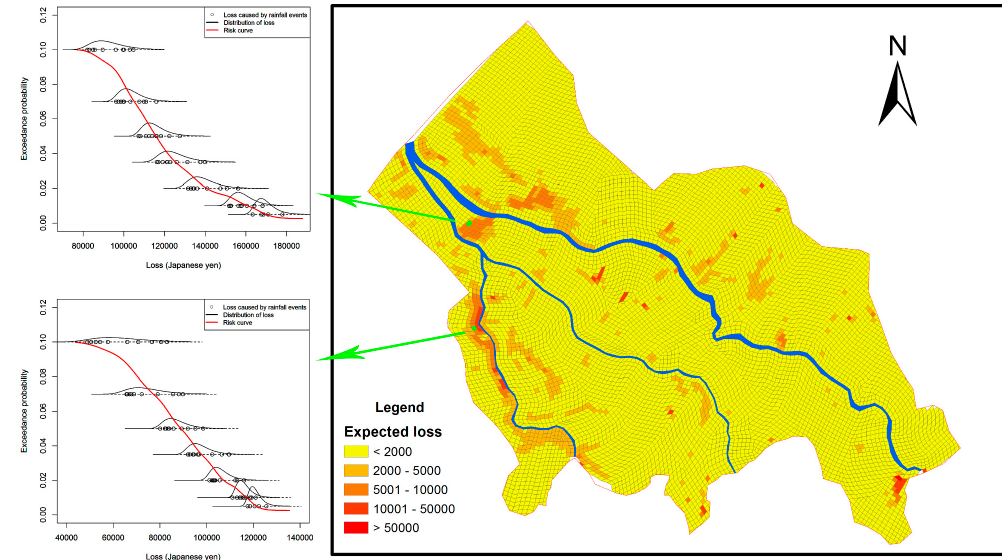
Figure 11. Spatial flood risk map for expected economic loss and three examples for risk curves at different locations. (The exchange rate between U.S. dollar and Japanese yen is about 1:111).